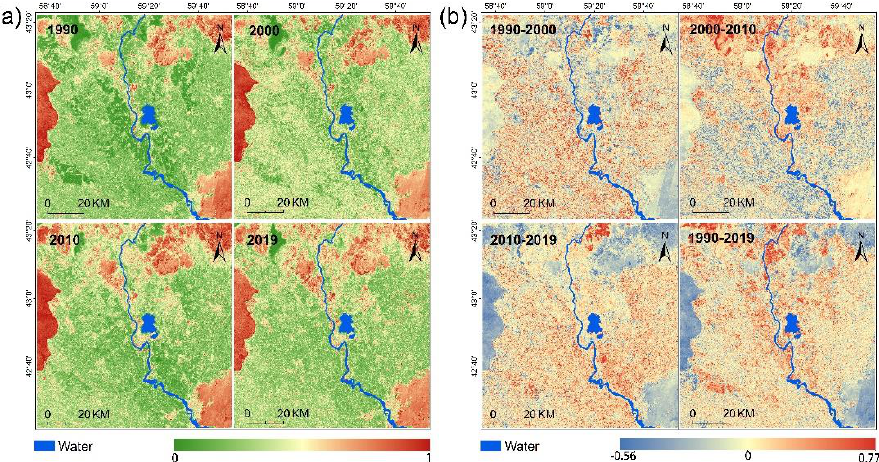
Figure 9. Spatial distribution of soil salinization from 1990 to 2019 ( a ) and spatial distribution of the salinity index (SI) changes between different periods ( b ).